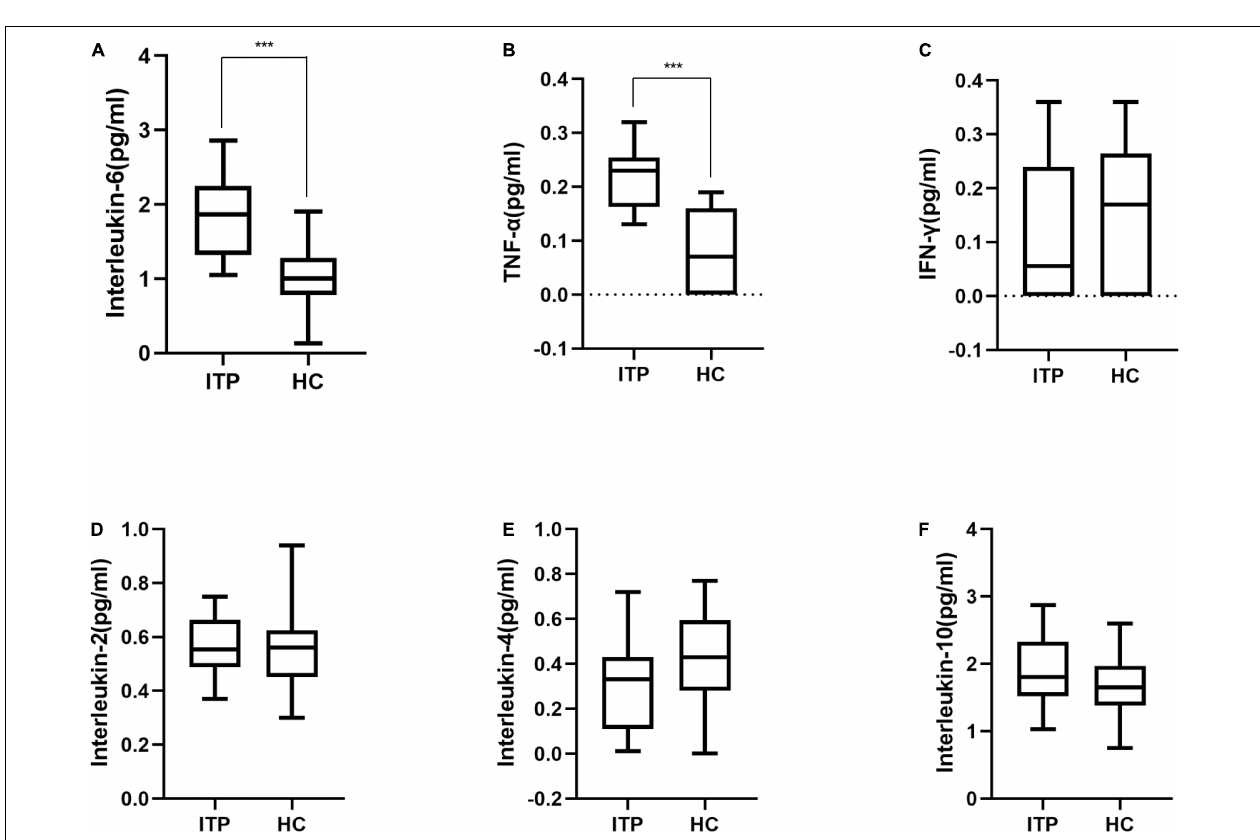
(Ratio ≥ 2 or ≤ 1/2), t -test ( P value<0.05), and